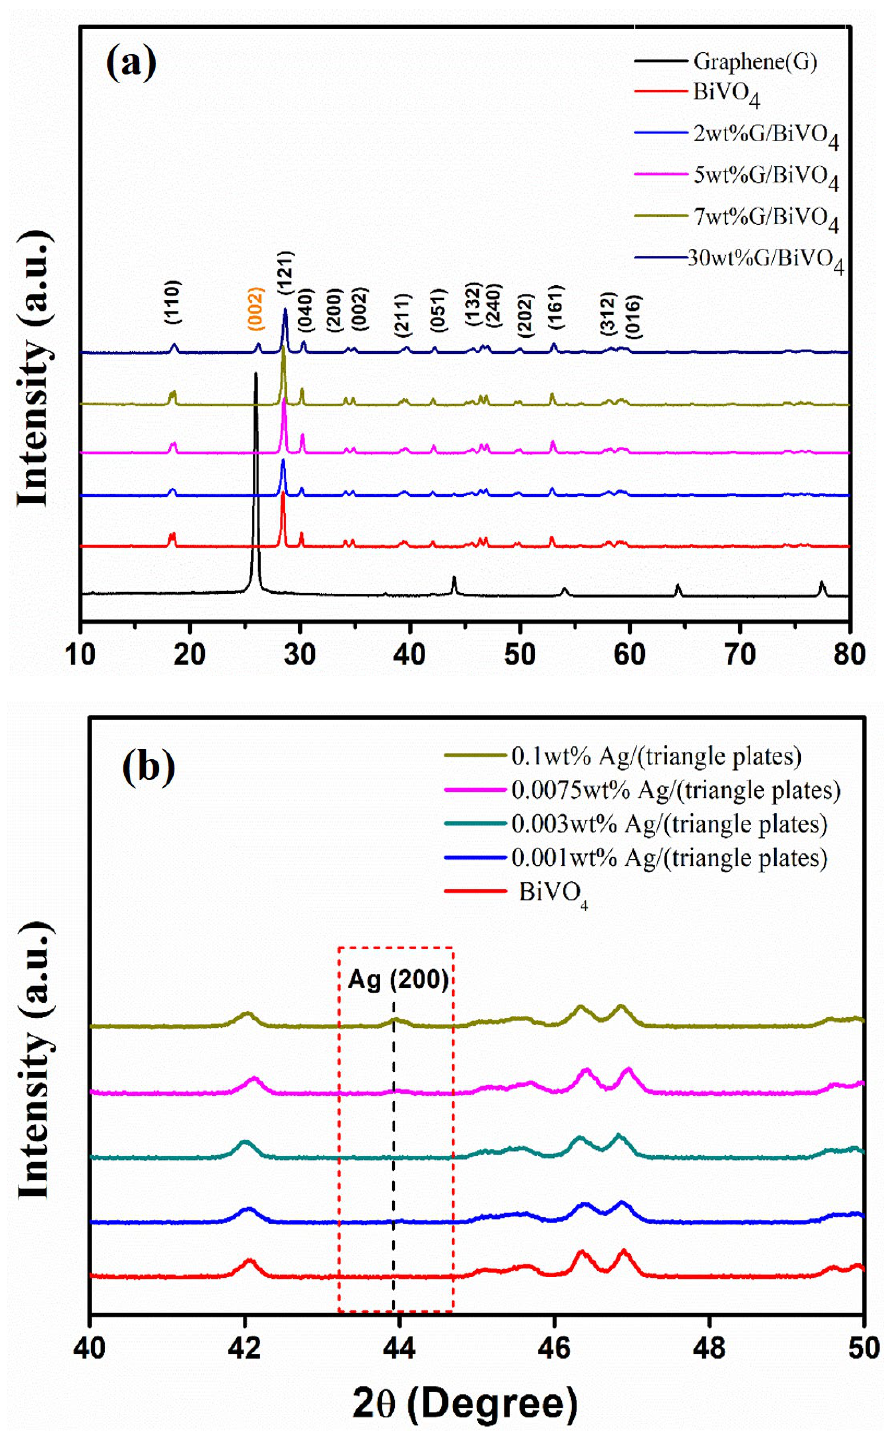
Figure 1. XRD patterns of the obtained photocatalysts ( a ) in the range of 2θ = 10 ° –80 ° and ( b ) in the range of 2θ of 40 ° –50 ° .